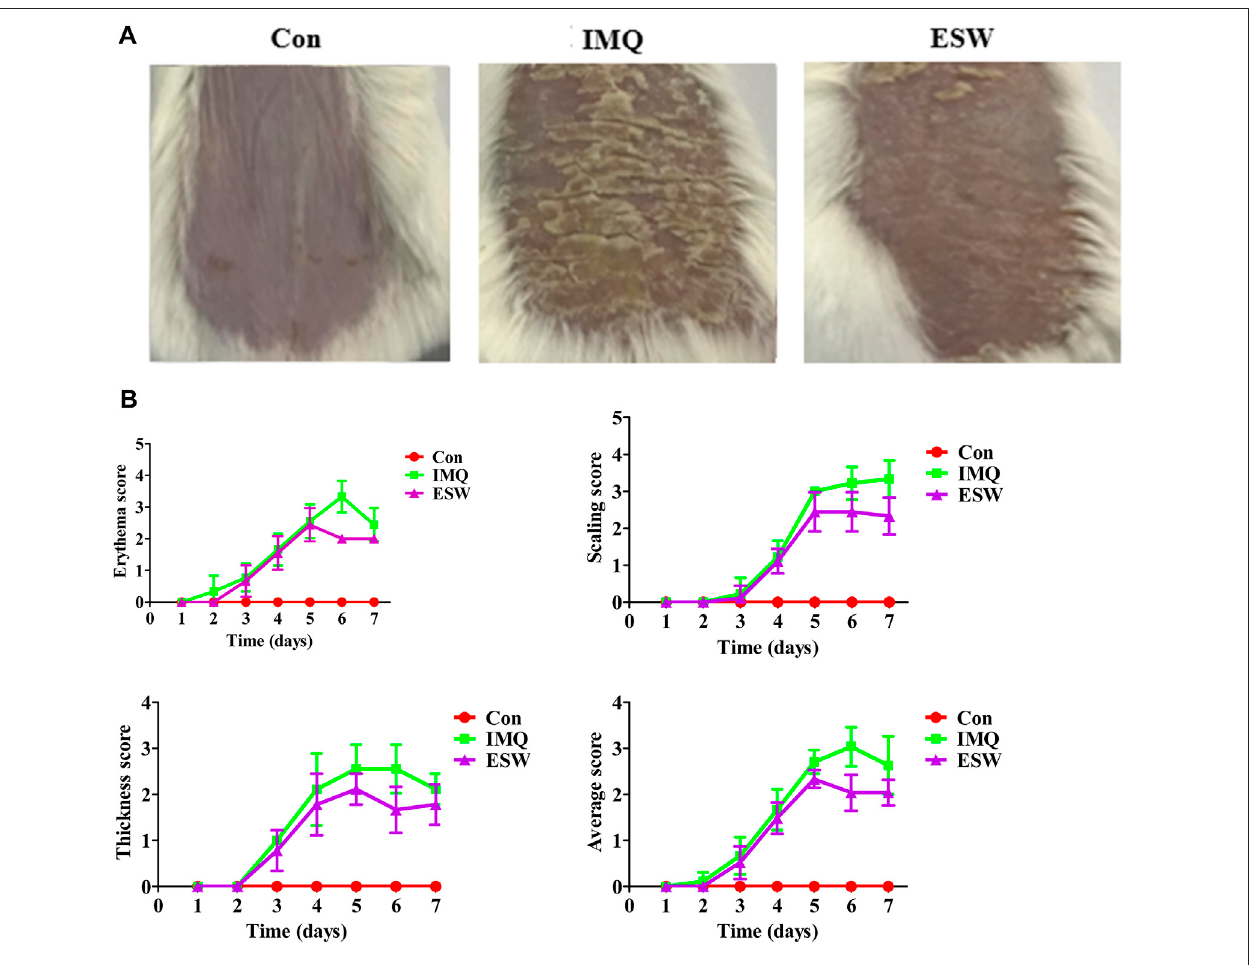
FIGURE2| ESWalleviatedtheseverityofIMQ-inducedpsoriasis-likeskinin fl ammation. (A) Representativephotosofthelesionalskinofmicefromeachgroup. (B) The PASI scores oferythema score,scaled score,thickness score, and averagescorein each group from day 1today 7. All datawere expressed asmean ± SD ( n (cid:2) 8).